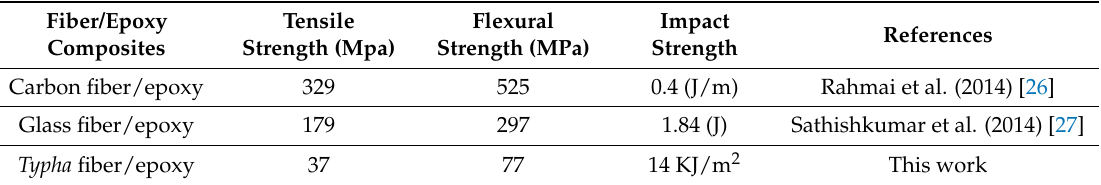
Figure 5. Impact strength of untreated and treated Typha fiber reinforced epoxy composite. Table 2. Comparison of Mechanical properties of Typha reinforced epoxy fiber with carbon fiber/epoxy and glass fiber epoxy composites.